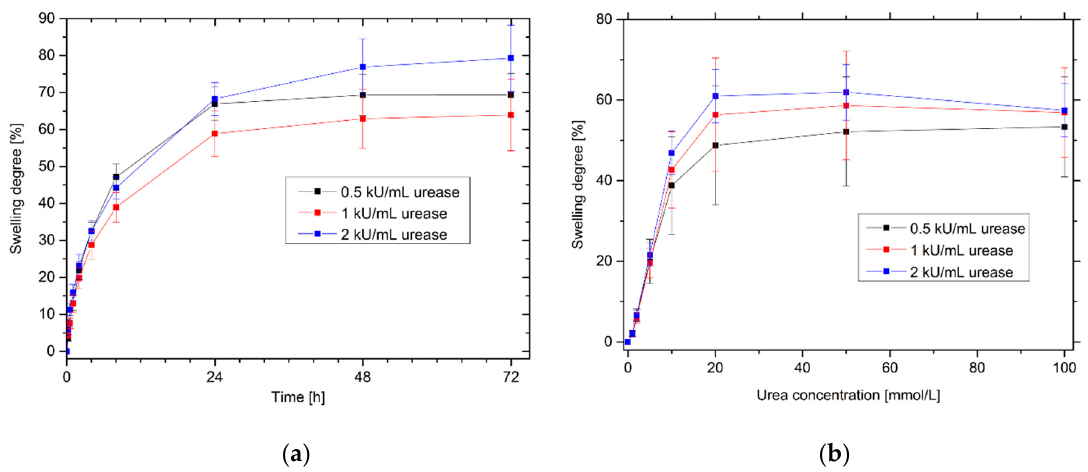
Figure 7. Influence of the amounts of enzyme for urea-sensitive hydrogels on the ( a ) swelling kinetics in a 20 mmol/L urea solution and ( b ) swelling behavior for different urea concentrations.